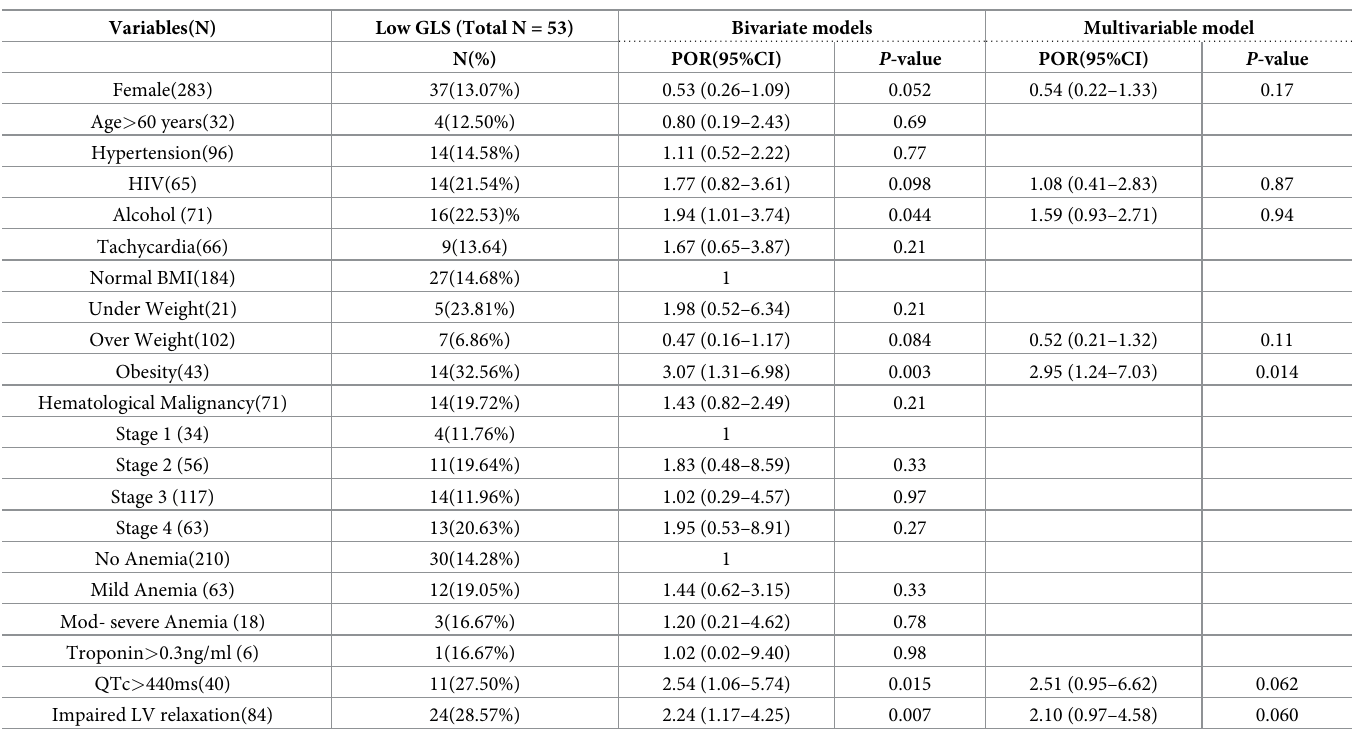
Table 3. Association of low GLS and